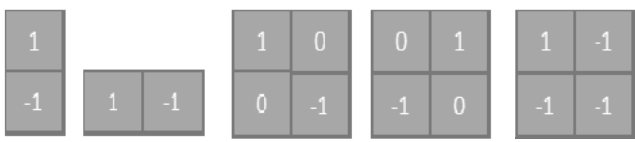
Figure 1. The architecture of the predefined filters.